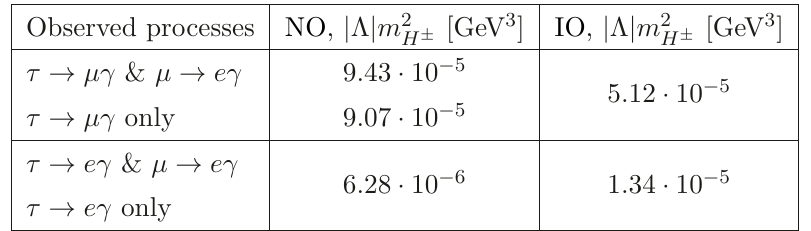
Λ m 2 , if the only specified combination H ± | |